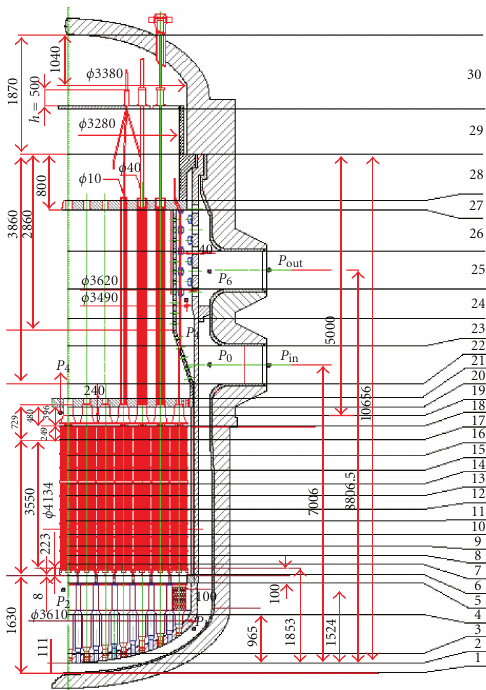
Figure 7: TRACE axial nodalization of the RPV.